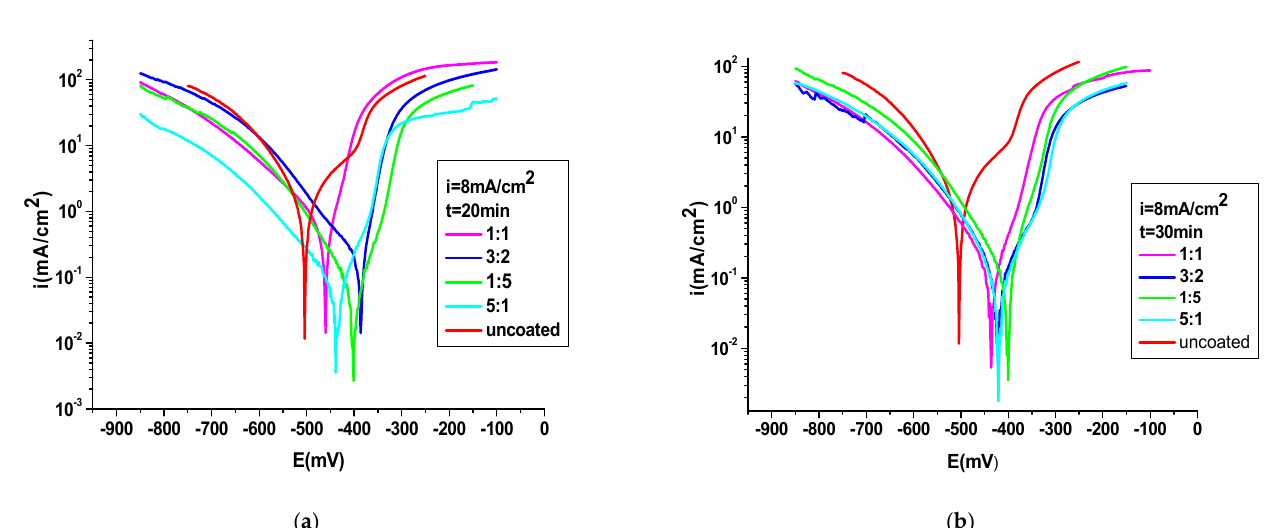
Coatings 2021 , 11 , 903 Figure 7. Polarization curves PNMPY-TRX100/PNNDEA ( a ) coated and ( b ) uncoated of OL 37 in 0.5 M H 2 SO 4 by electrodeposition at 8 mA/cm 2 current density at various molar ratios where the deposition was allowed for 20 and 30 min.